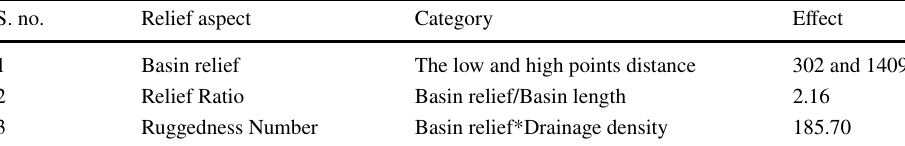
Table 5 Relief aspect of the Vaniyar sub